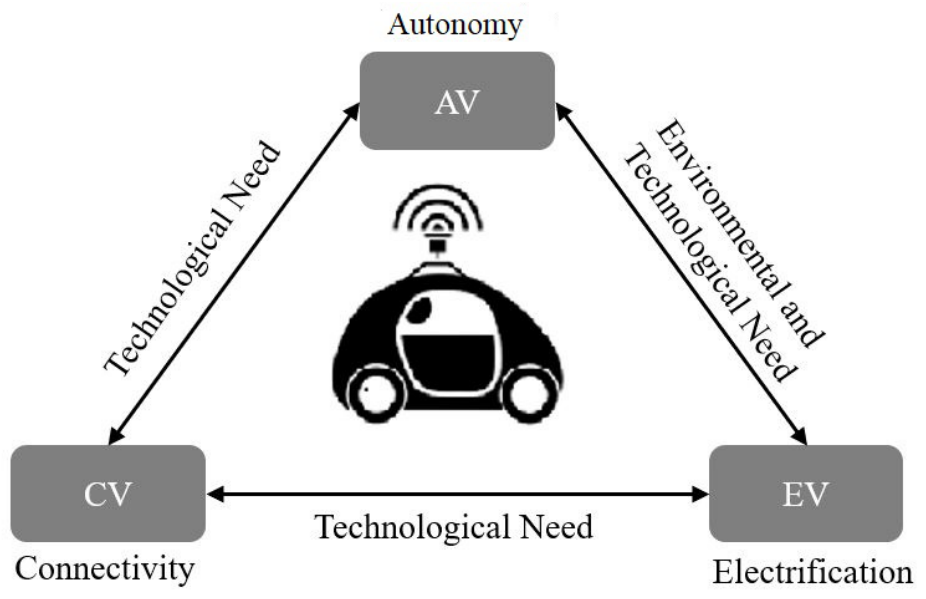
Figure 1. Technologies that demonstrate the potential of automobiles (adapted from [2]).